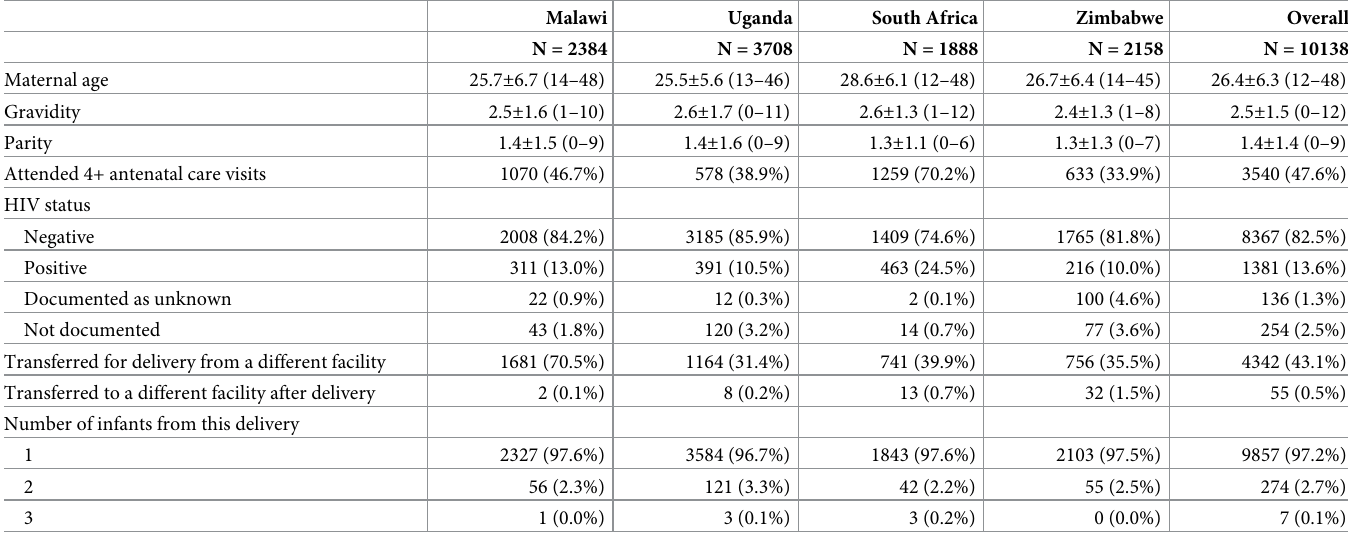
Table 3. Maternal characteristics at data abstraction overall and by site.